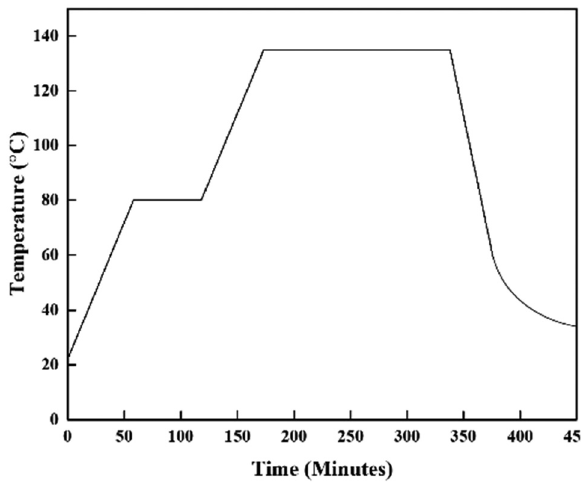
Figure 1: Curing cycles in the specimen manufacturing process for equivalency testing.